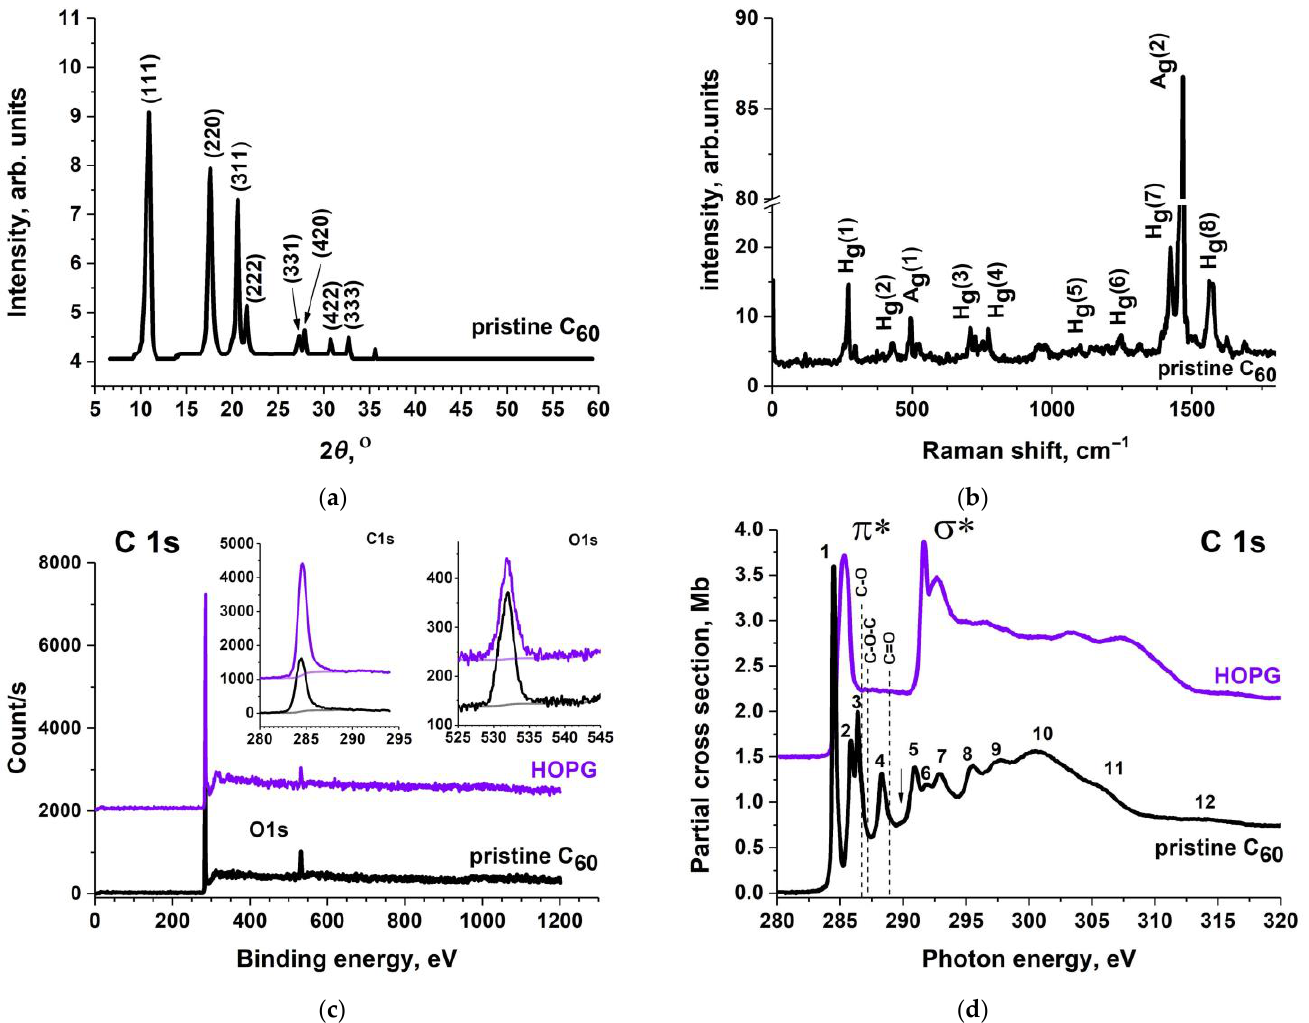
Figure 1. Characterization of the pristine C 60 powder and HOPG: ( a ) C 60 XRD pattern; ( b ) C 60 Raman spectra; ( c ) survey XPS spectra of the C 60 and HOPG, the inset shows their C 1s and O 1s XPS spectra; ( d ) C 1s NEXAFS spectra of the C 60 and HOPG (shifted at the vertical scale by 1.5 Mb). The arrow in ( d ) indicates the position of the fullerite C 60 C 1s absorption edge (289.60 eV) [42]. The positions of the absorption bands in the atomic groups C=O (288.9 eV), C–O–C (287.2 eV) and C–O (286.7 eV) [43] are marked with dashed lines.